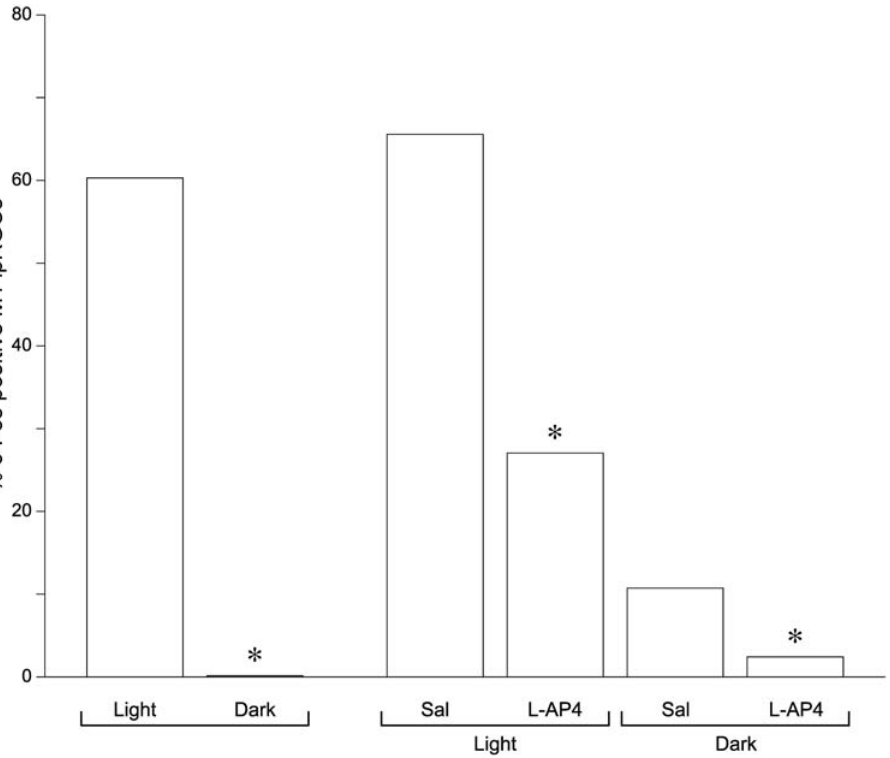
Figure 2. Light-induced c-Fos expression in ipRGCs lacking melanopsin. The percentage of b -galactosidase-positive ipRGCs expressing Fos in the retinas of tau-lacZ + / + mice three hr after light onset or at the same time of day but in the dark is shown on the far left of the histogram (white light=1000 lux; n=3 animals; dark=0 lux; n=2 animals) (*=p , 0.0001, Fisher’s exact test). The percentage of b -galactosidase-positive ipRGCs expressing Fos in the retinas of tau-lacZ + / + mice receiving an intravitreal injection of saline (sal) in one eye and L-AP4 in the other eye under dim red light conditions and killed after 3 h exposure to room light (white light=1000 lux; n=3 animals) or after 3 h exposure to complete darkness (dark=0 lux; n=3 animals) is provided on the right side of the histogram (*=p , 0.0001, Fisher’s exact test, sal vs